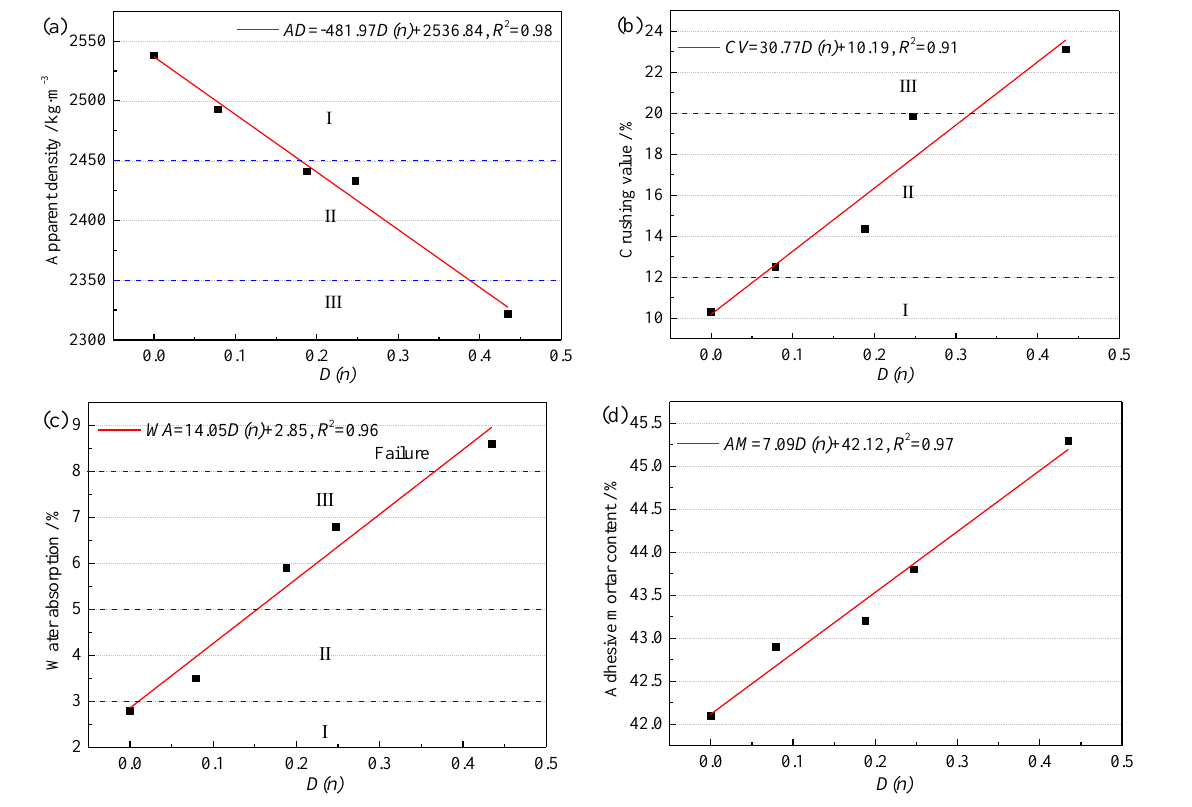
Figure 8. Variation law of apparent density ( a ) crushing value ( b ) water absorption ( c ) and adhesive mortar content ( d ) of RCA with F-T damage of parent concrete.